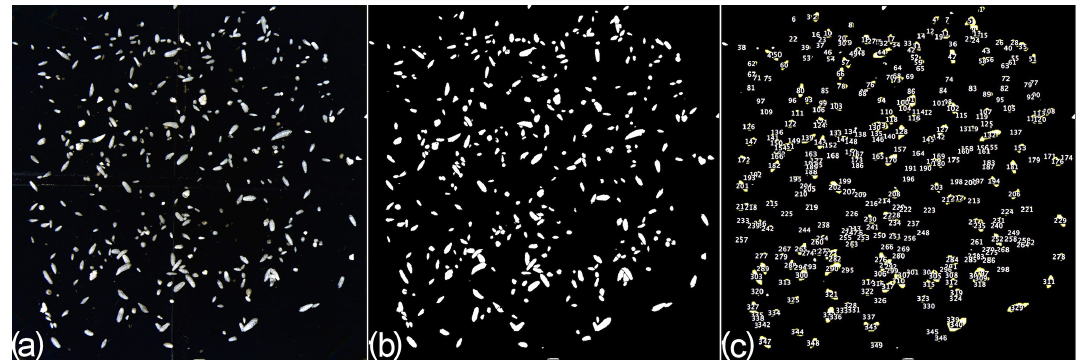
Figure 2. Principal steps of the automated image analysis within the MorFo macro. (a) Original stereoscopic microscope image. (b) Binarized image and watershed. (c) Automated counting and measurements. The illustrated sample originates from Core MD02-2508, sample 240–